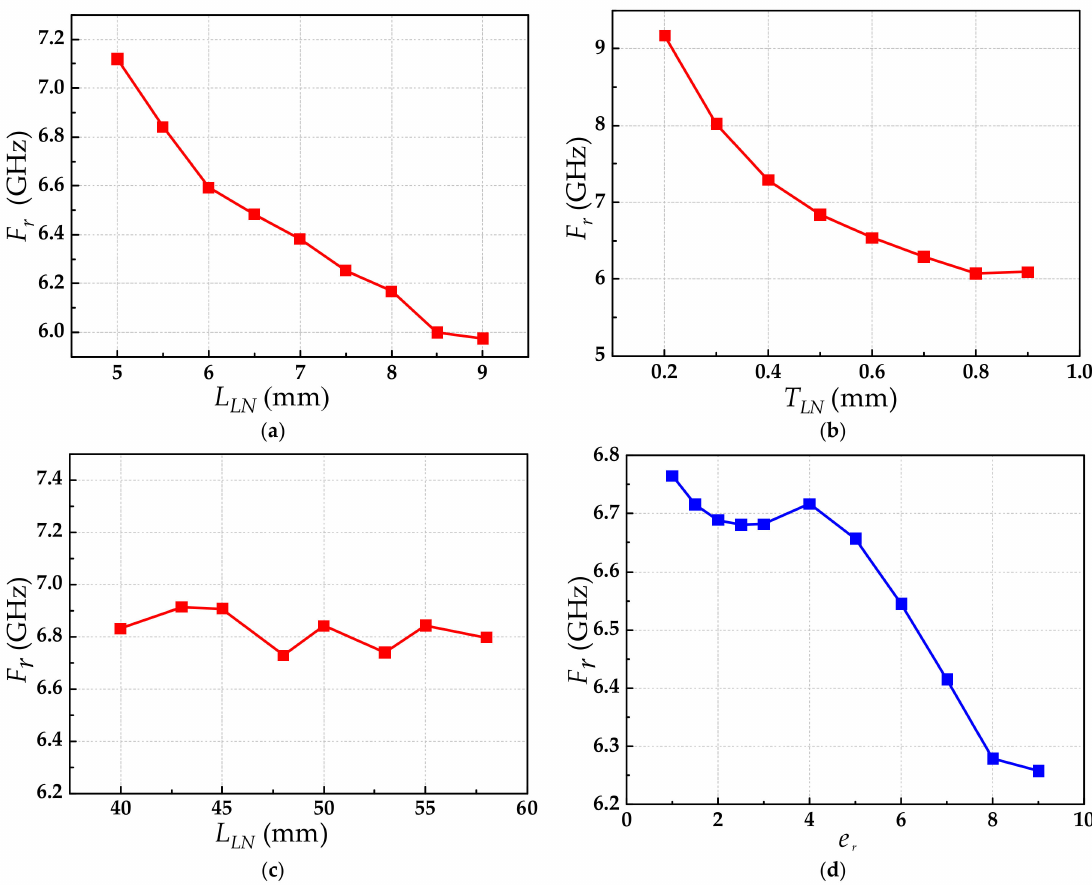
Figure 4. The relationships between the resonance frequency F r and the LN substrate and the relative permittivity of the packaging material: ( a ) F r versus W LN ; ( b ) F r versus T LN ; ( c ) F r versus L LN ; ( d ) F r versus ε r